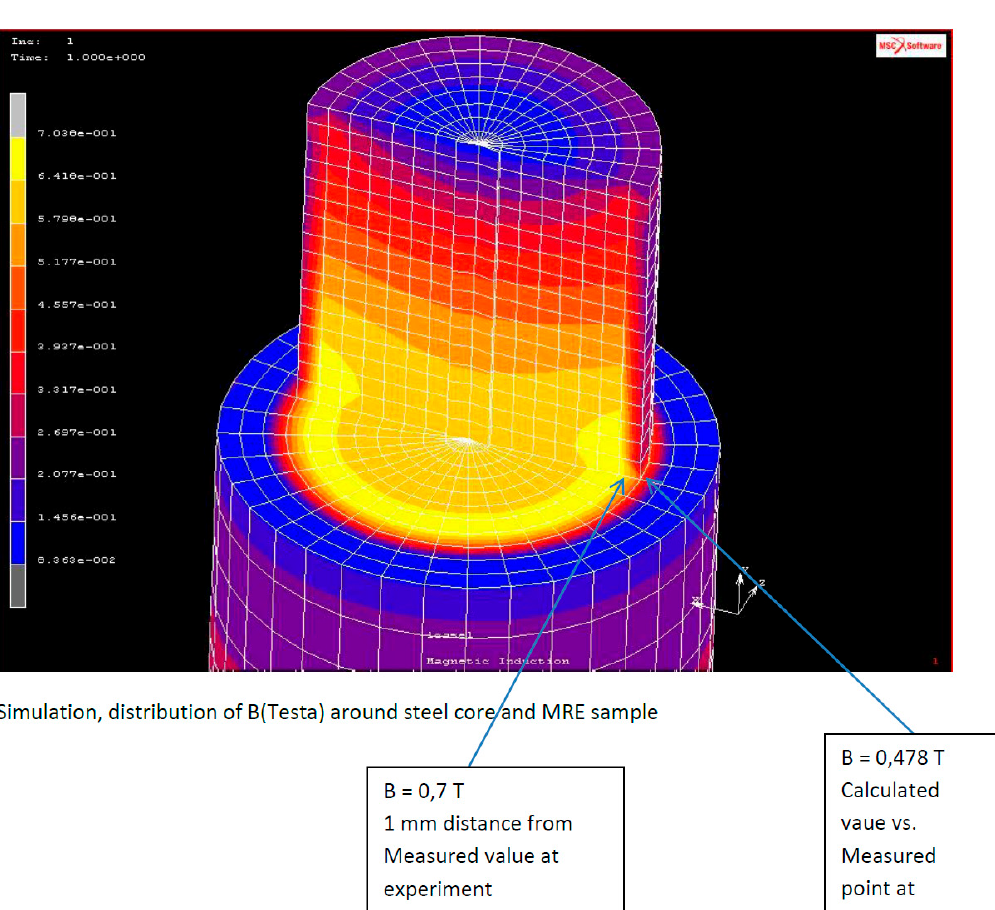
Figure 11. Distribution of magnetic induction in the MRE composite.